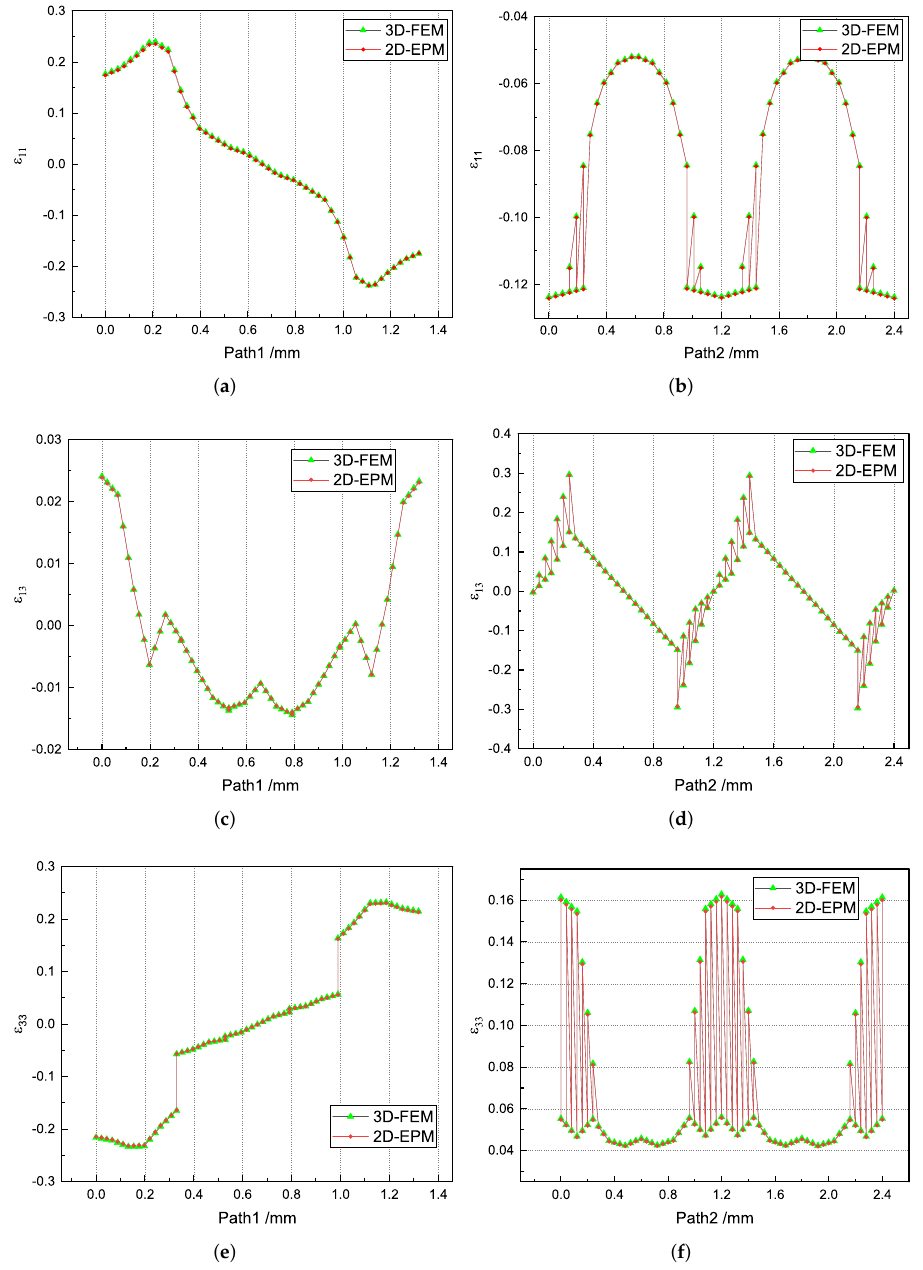
Figure 11. Comparison of local strain curves along Path 1 and Path 2 of the unit cell predicted by two models under the conditions in Case 2. ( a ) ε 11 along Path 1; ( b ) ε 11 along Path 2; ( c ) ε 13 along Path 1; ( d ) ε 13 along Path 2; ( e ) ε 33 along Path 1; and ( f ) ε 33 along Path